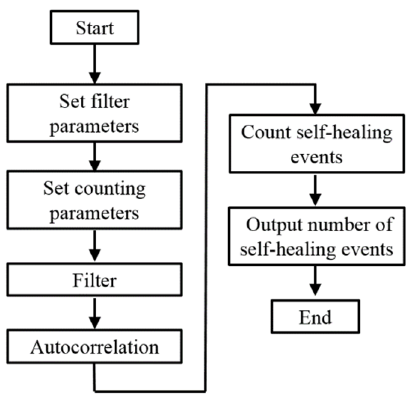
Figure 16. Process diagram of the main program in the detection software.